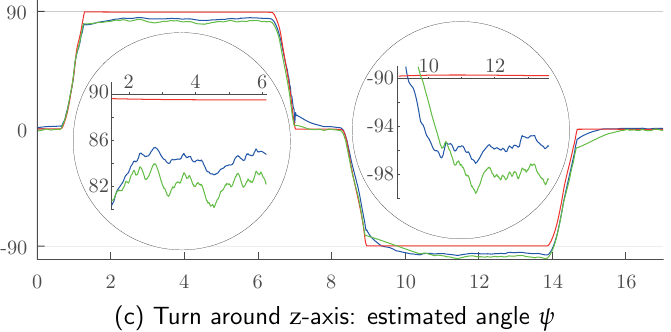
Figure 5. Turn around each axis: estimated angle (deg) vs. time